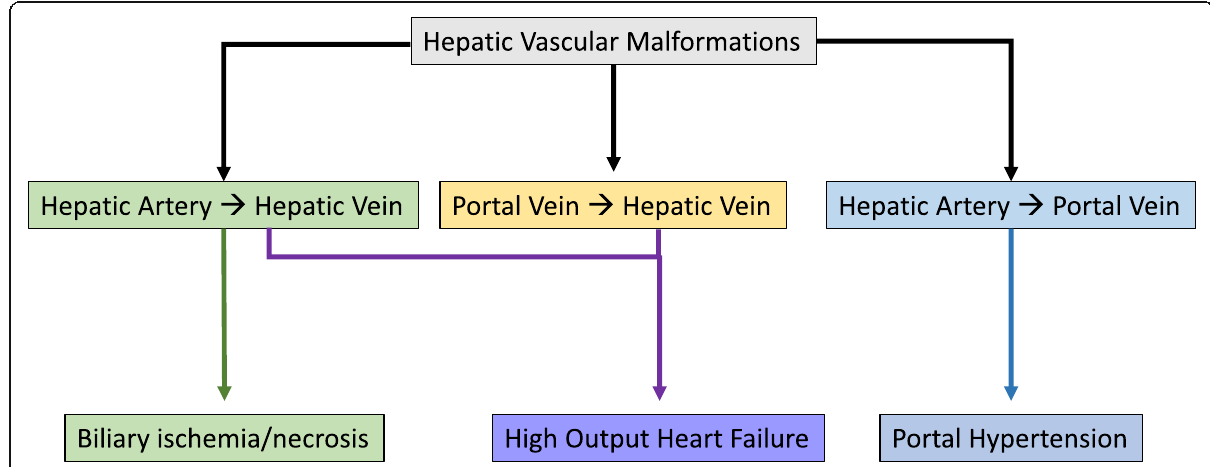
Fig. 7 Manifestations of Hepatic Vascular Malformation Shunts. Hepatic artery to hepatic vein shunts can result in biliary ischemia and necrosis due to the single blood supply to the biliary system from the peribiliary plexus via the hepatic artery. Shunting to the hepatic vein such as through hepatic artery to hepatic vein shunting and portal vein to hepatic vein shunting, contribute to high output heart failure. Hepatic artery to portal vein shunts leads to portal hypertension